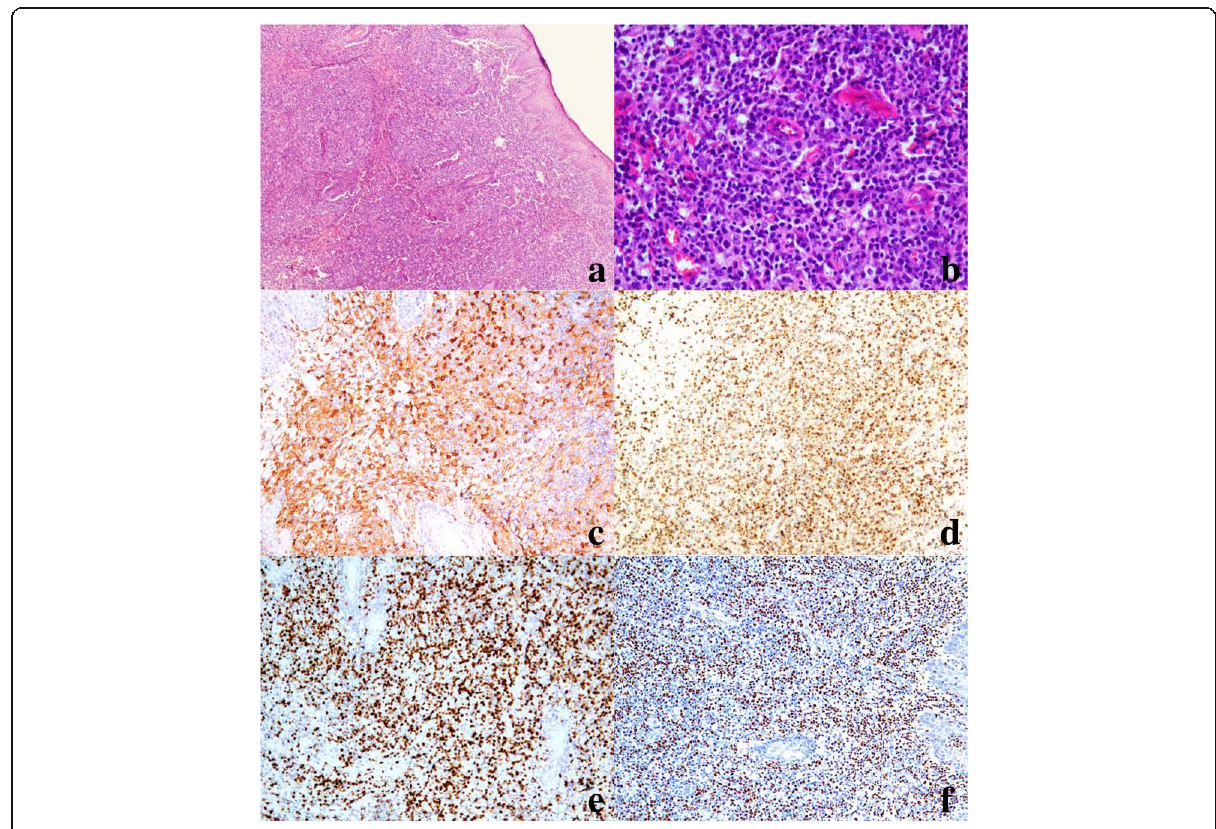
Fig. 3 Morphology and immunophenotype of case 9, which progressed to systemic T-cell lymphoma. a Skin biopsy shows a diffuse, atypical lymphocyte infiltrate, with a marked epidermis and subcutaneous distribution (hematoxylin and eosin stain [H&E], 40×). b Skin biopsy shows medium- to large-sized lymphocytes, with enlarged, oval and pleomorphic nuclei (H&E, 200×). c Strong staining of CD4+ cells (IHC, 200×). d GranB Positive cells (IHC 100×). e Ki67 expression is high in 70% of tumor cells (IHC 100×). f In situ hybridization shows that neoplastic cells are positive for EBV-encoded RNA